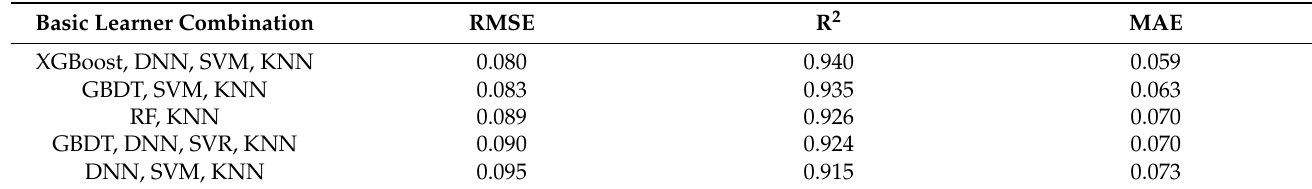
Table 7. Prediction error stacking for various base learner combinations.